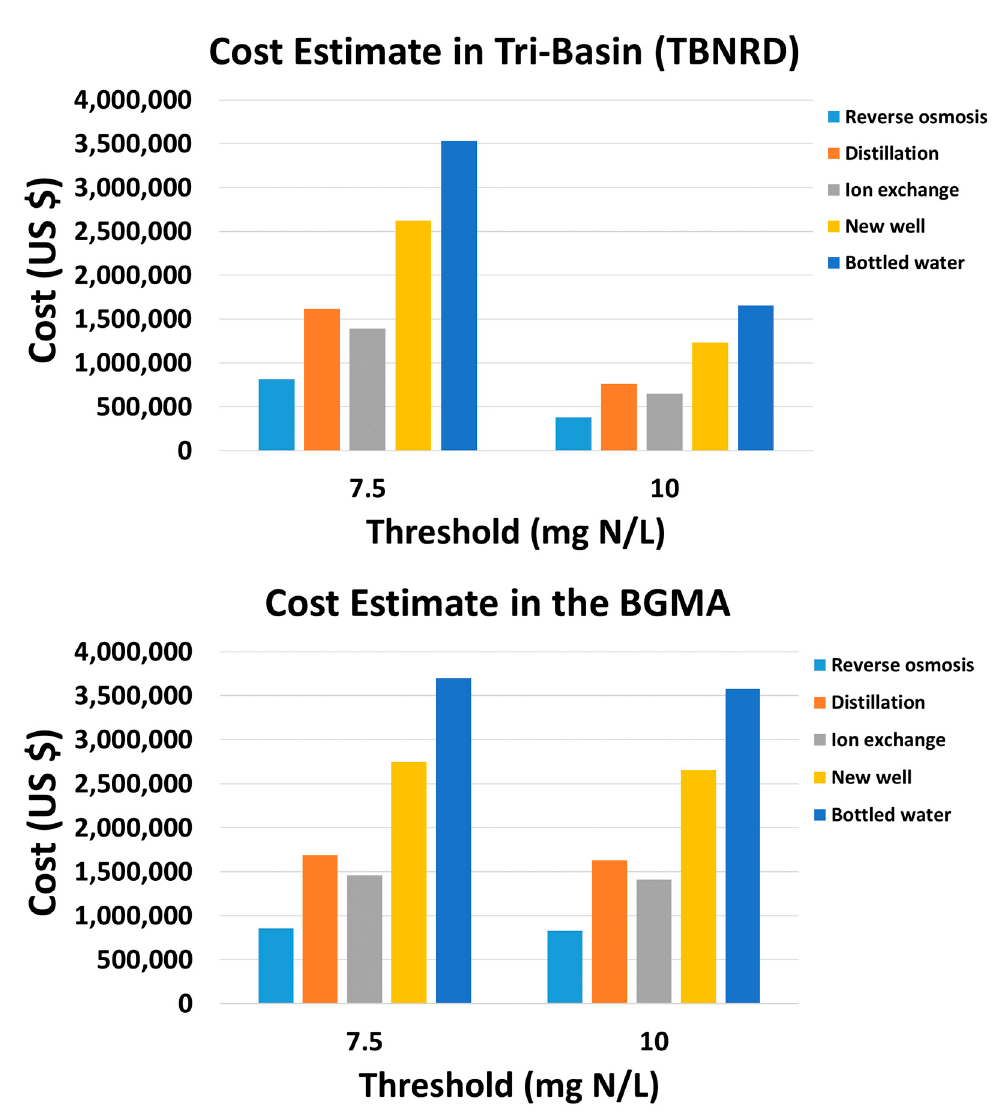
Figure 7. Mean 20-year cost of household options for domestic wells predicted to be at risk of nitrate contamination.